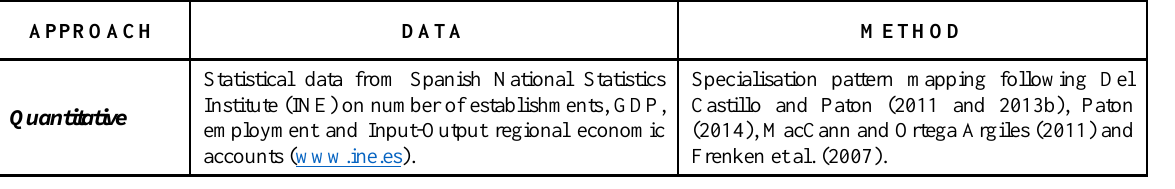
Table 3: Research